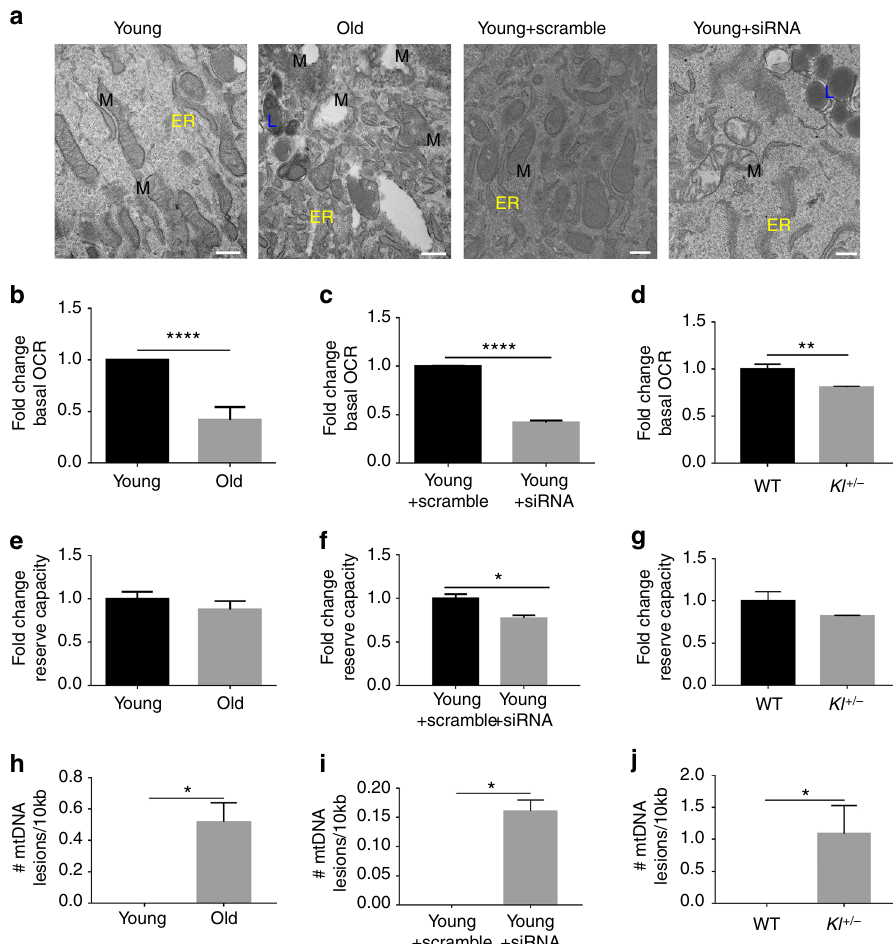
Fig. 4 Loss of α -Klotho drives mitochondrial dysfunction and disrupts mitochondrial DNA integrity. a TEM images of young, old, young + scramble and young + siRNA MPCs showing mitochondria (M), lipid droplet accumulation (L), as well as endoplasmic reticuli (ER). Scale: 400 nm. b , c Seahorse analysis of young, old, young + scramble and young + siRNA MPCs quantifying the basal oxygen consumption rate (OCR). d Seahorse analysis of basal OCR of MPCs isolated from wild-type and Kl + / − mice. e , f Seahorse analysis of reserve capacity (calculated as the difference between basal and maximum OCR) of young, old, young + scramble and young + siRNA MPCs. g Seahorse analysis of reserve capacity of MPCs isolated from wild-type and Kl + / − mice. h , i RT-qPCR based analysis of mtDNA damage in young, old, young + scramble and young + siRNA MPCs. j RT-qPCR analysis of mtDNA damage in MPCs isolated from wild-type and Kl + / − mice (* p < 0.05, ** p < 0.01, **** p < 0.0001, one-tailed Student ’ s t test). Data represented as mean ±